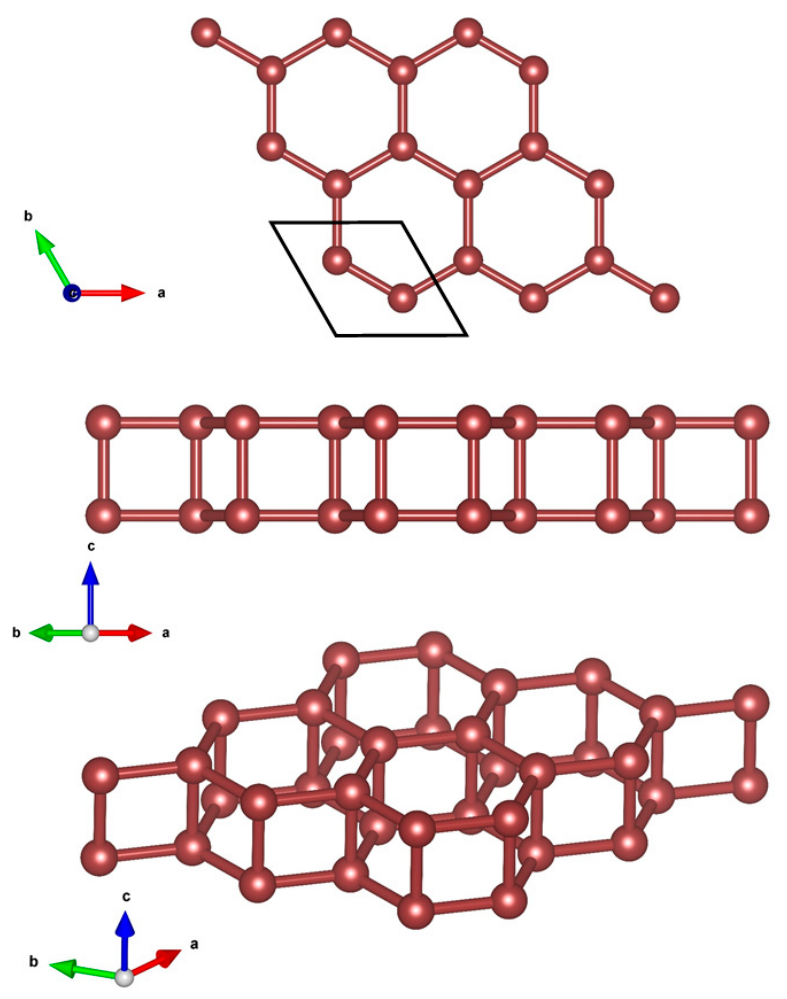
Figure 1. Crystal structure of 2D hexatetra-carbon from different views.